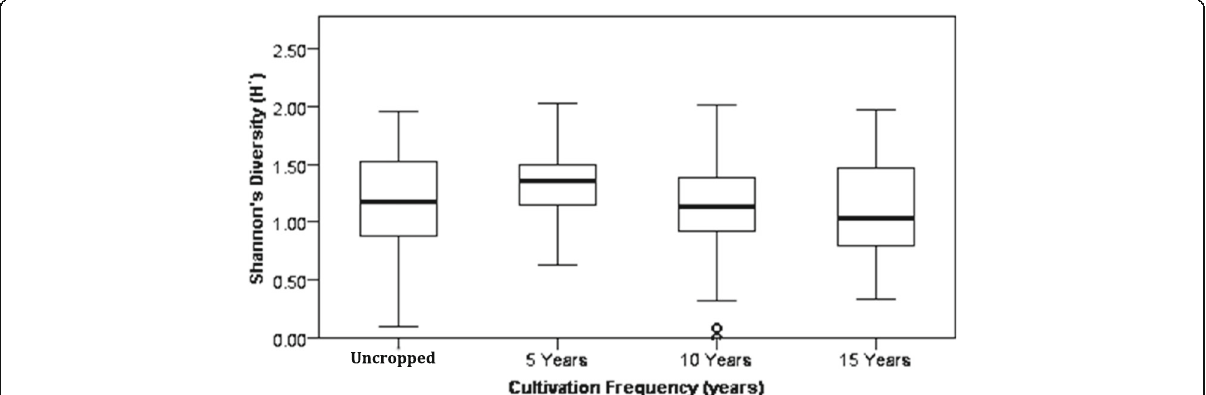
Fig. 7 Graphical representation of the independent-samples Kruskal – Wallis test on Shannon ’ s diversity index across the study sites